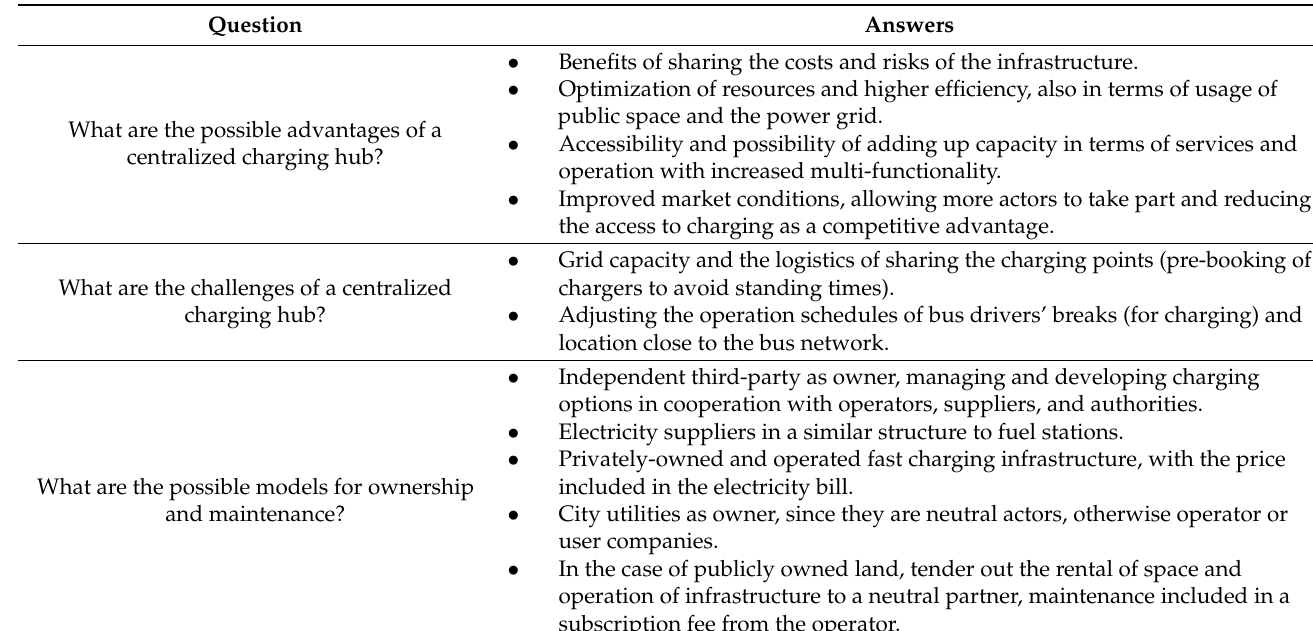
Table 7. Results of the